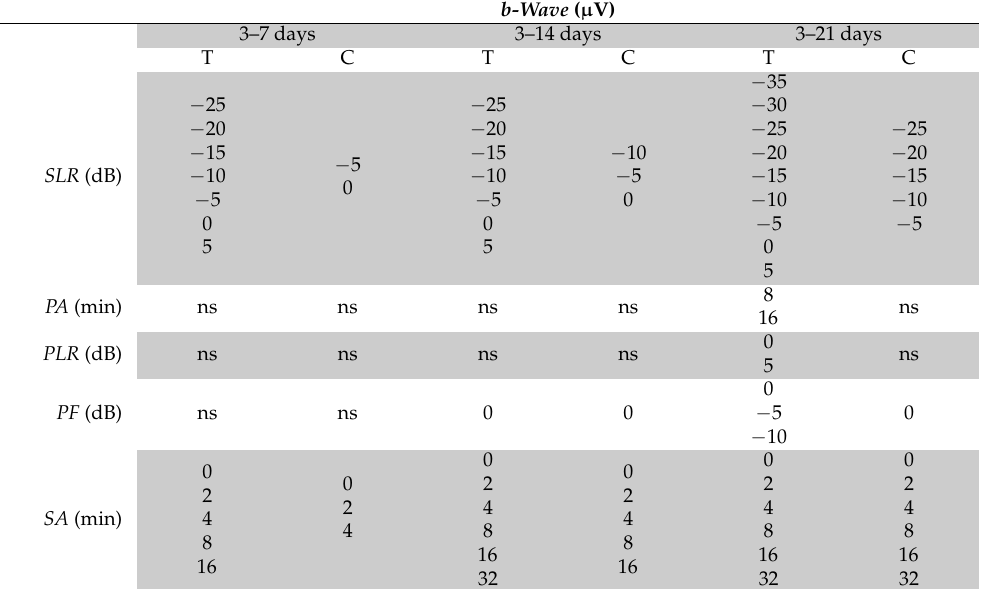
SLR, scotopic luminescence response; PA, photopic adaptation; PLR, photopic luminescence re- sponse; PF, photopic flicker; SA, scotopic adaptation; dB, decibel; min, minutes. When studying the differences between the timepoints T3 (retinal damage baseline), T7, T14, and T21, significant differences between the treated and control groups were found. Mean values were analyzed ( n = 4 per group/timepoint) and statistically significant differences ( p < 0.05) were evaluated in each step of the ERG. Table 4 summarizes the comparison between groups/timepoints. Table 4. ERG (b-wave) comparison between timepoints T3 and T7, T14 and T21 after glaucoma induction in the OD, both in treated and control groups. Results show the ERG steps (in dB or min) with statistically significant differences ( p < 0.05) between timepoints.